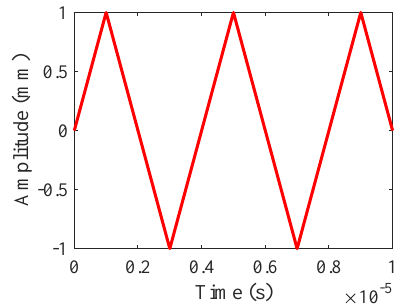
Figure 3. Displacement signal for the right side boundary condition of the verifying model.